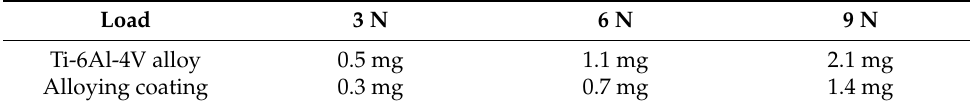
Table 2. The abrasion loss of Ti-6Al-4V alloy and alloying coating under different load.